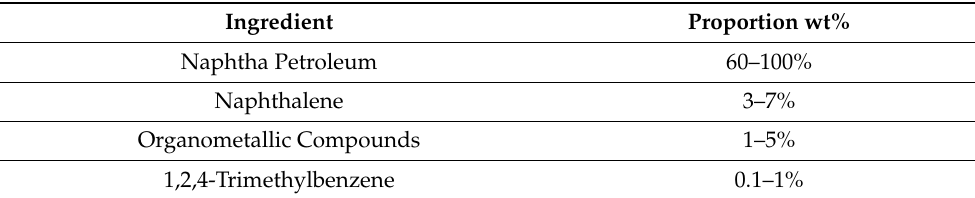
Table 1. FMAX composition [39].